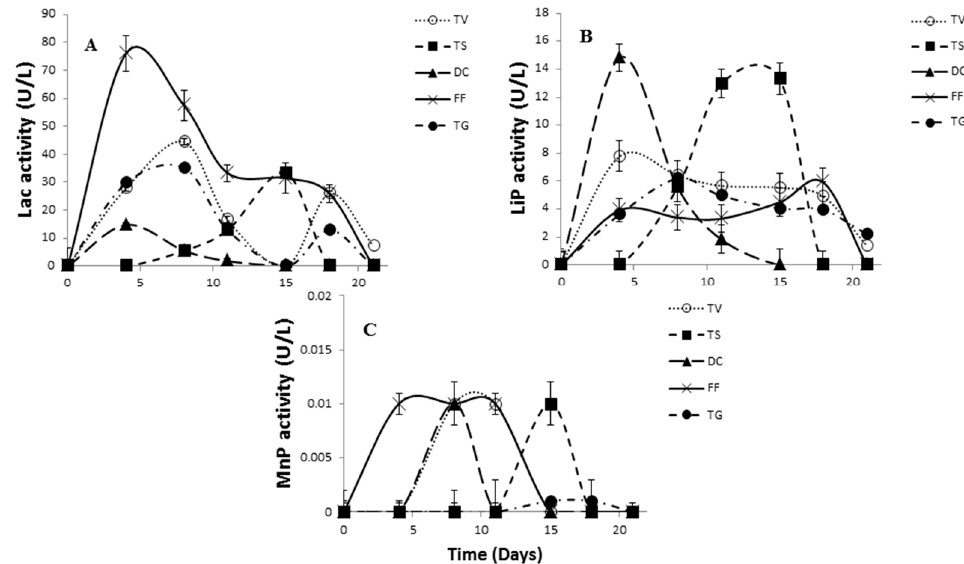
Figure 3. Evaluation of laccase (Lac) ( A ); lignin peroxidase (LiP) ( B ) and manganese-dependent peroxidase (MnP) ( C ) activities of tested white-rot fungi without induction. Standard deviation lines represent the variation of mean activity value obtained from three replicate cultivations. The strains and abbreviations: Trametes versicolor (TV); Trametes suaveolens (TS); Daedaleopsis confragosa (DC); Fomes fomentarius (FF); Trametes gibbosa (TG).